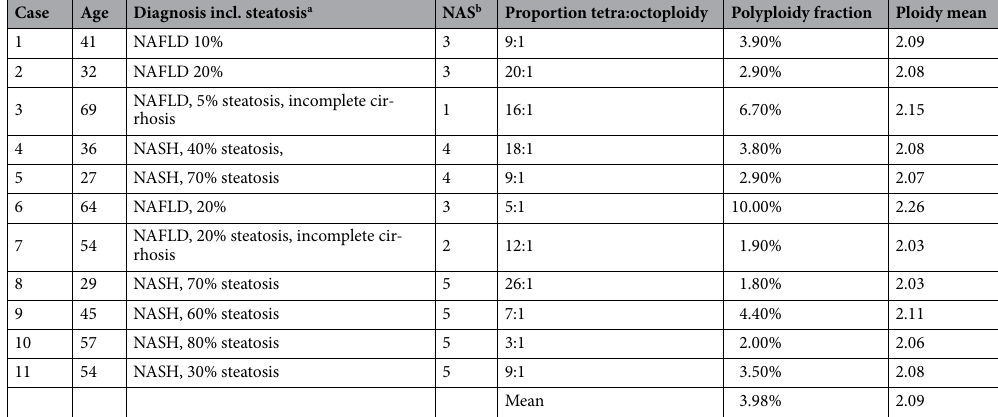
Table 2. Single-cell ploidy in nonalcoholic fatty liver disease (NAFLD) and nonalcoholic steatohepatitis (NASH) patient specimens. a Diagnosis with macrosteatosis. b Nonalcoholic steatohepatitis activity score, including three criteria: macrosteatosis, hepatocellular ballooning and lobular inflammation; high scores means more severe disease, i.e. manifest steatohepatitis is defined by a minimum score of